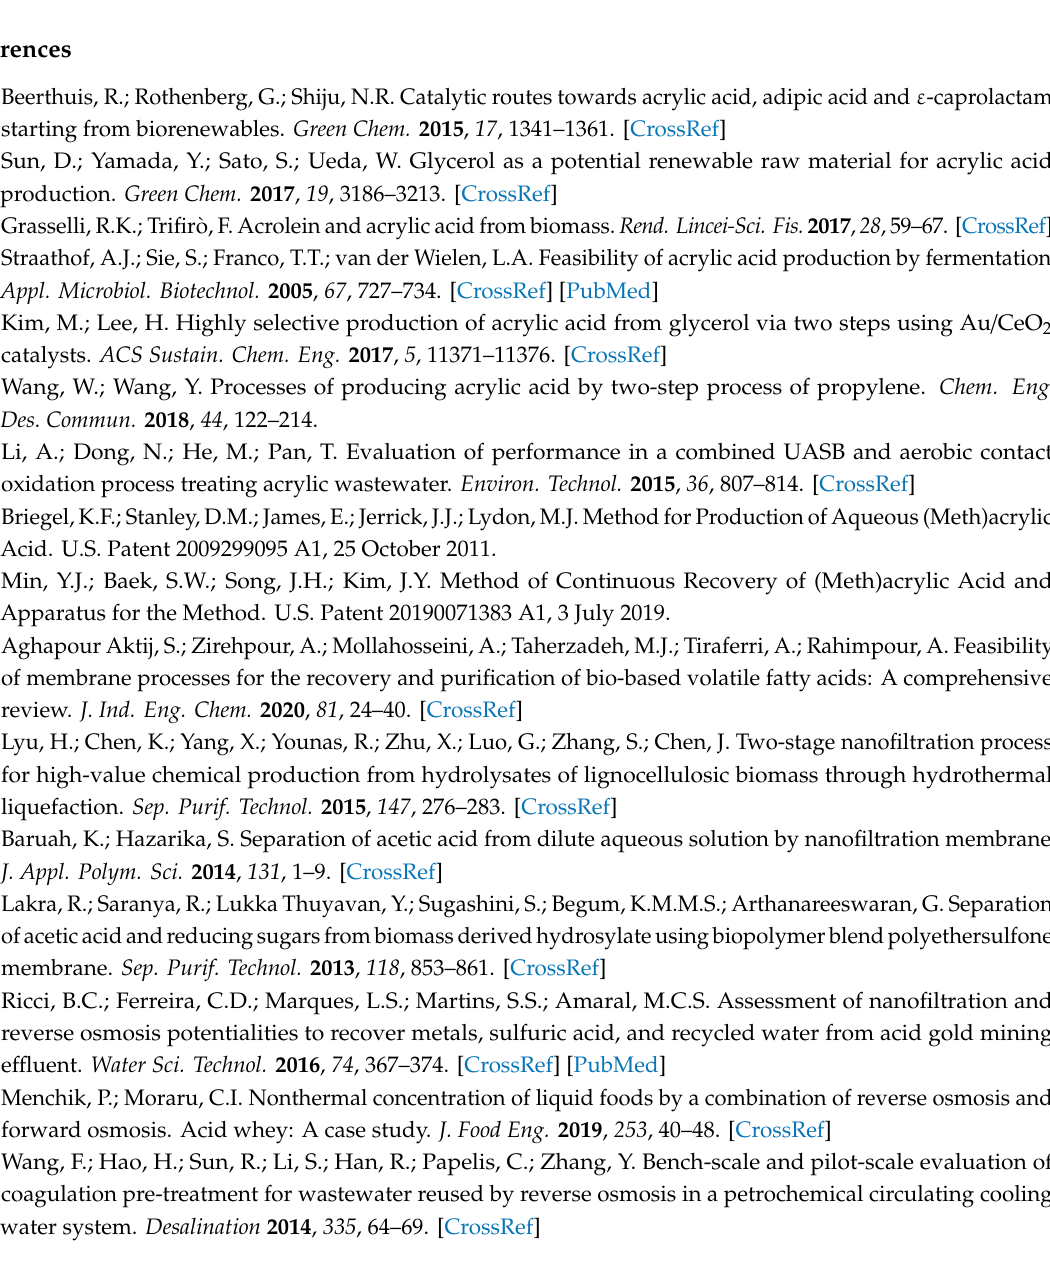
pressures, Figure S3: AFM images of RO membranes: (a,d) prior to exposure and (b,c,e,f) after 6 months of exposure to the acid solutions, Figure S4: The C1s spectra and N1s spectra of C5 membranes: (a,b) prior to exposure and (c–f) after 6 months of exposure to the acid solutions, Figure S5: The C1s spectra and N1s spectra of C6 membranes: (a,b) prior to exposure and (c–f) after 6 months of exposure to the acid solutions, Table S1: Comparison of the acetic retention with those in the